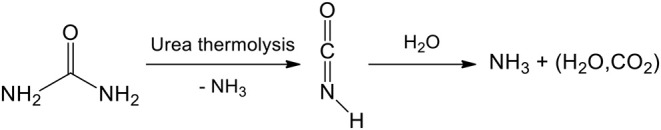
Urea decomposition in water. Isocyanic acid is slowly obtained by urea thermolysis and ammoniac release. A second ammoniac molecule is released by hydrolysis which gives aqueous carbon dioxide “H2CO3.”